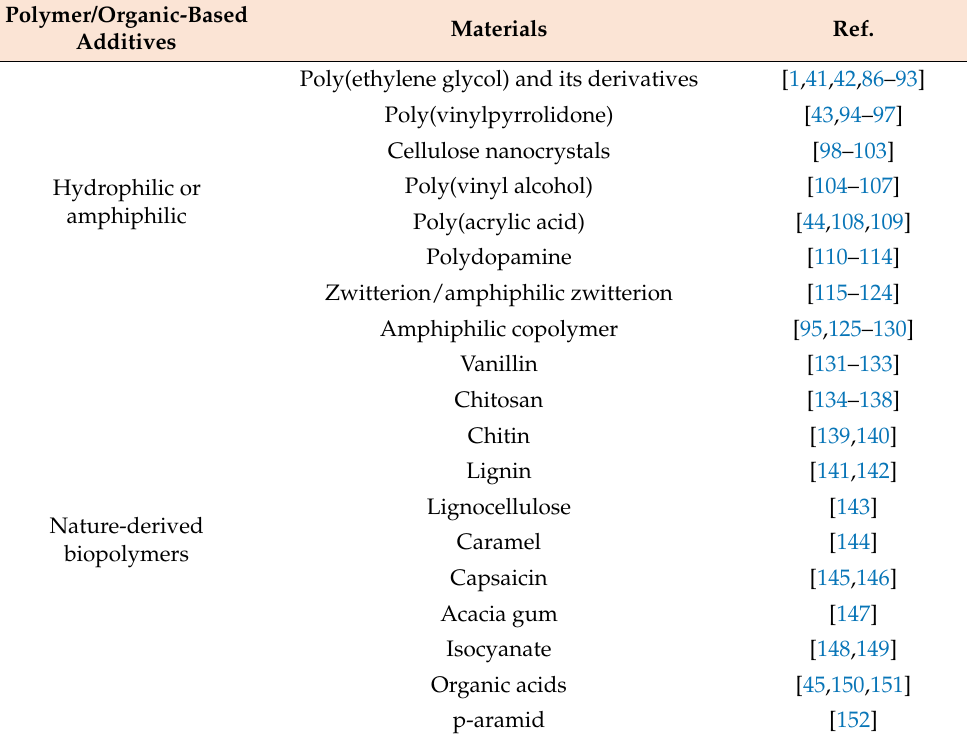
Table 1. Polymer/organic-based antifouling additives used in the last 10 years for the blending modification of polymeric